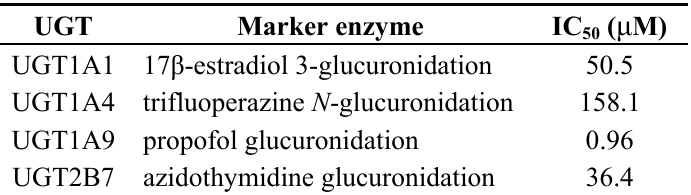
Table 3. Effect of honokiol on UGT metabolic activity in pooled human liver microsomes (H161).